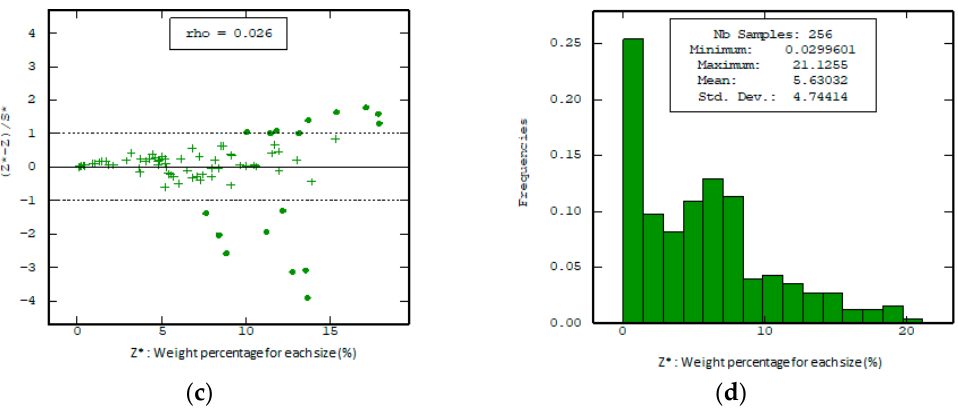
Figure A6. Cross-evaluation of the geostatistical analysis of LGP-2 with ore-B. ( a ) Scatter plot (identity line) where the x-axis represents the modeled data, and the y-axis represents the experimental data. ( b ) Standardized error histogram. ( c ) Standardized error based on the estimated value. ( d ) Histogram and its statistical parameters of the estimated data.